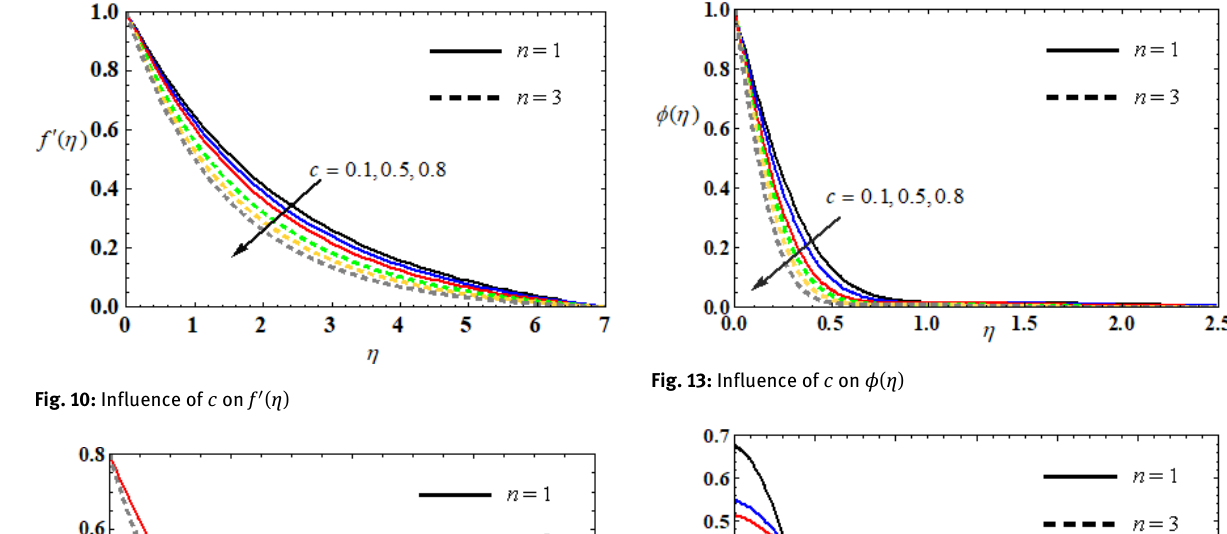
Fig. 10: Influence of c on f (cid:48) ( η )